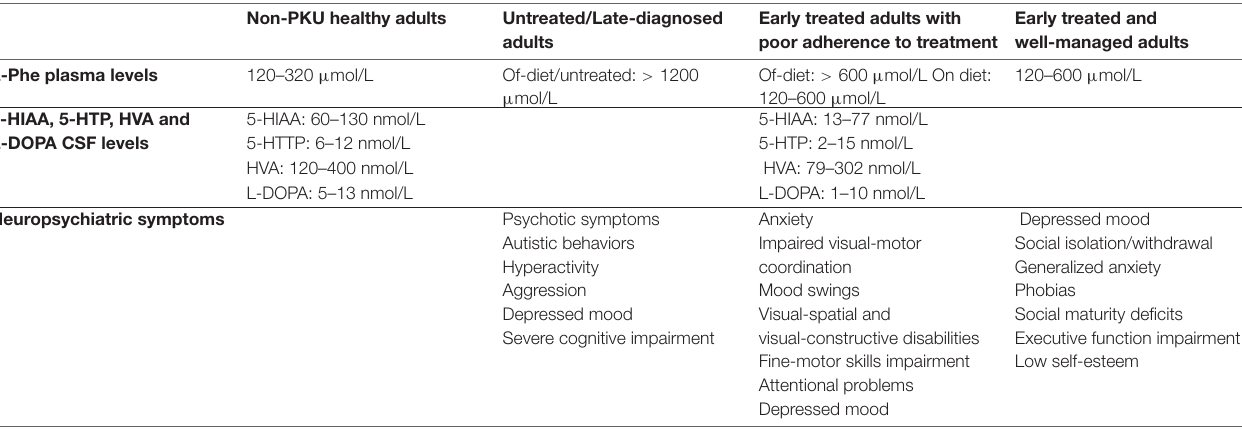
TABLE 1 | Phenylketonuria (PKU)-related neuropsychiatric symptoms and neurotransmitter deficiency as a function of treatment initiation/adherence. Non-PKU healthy adults Untreated/Late-diagnosed